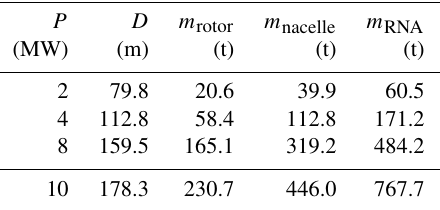
Table 2. Scaled rotor values for the SD-MRSs and initial DTU rotor